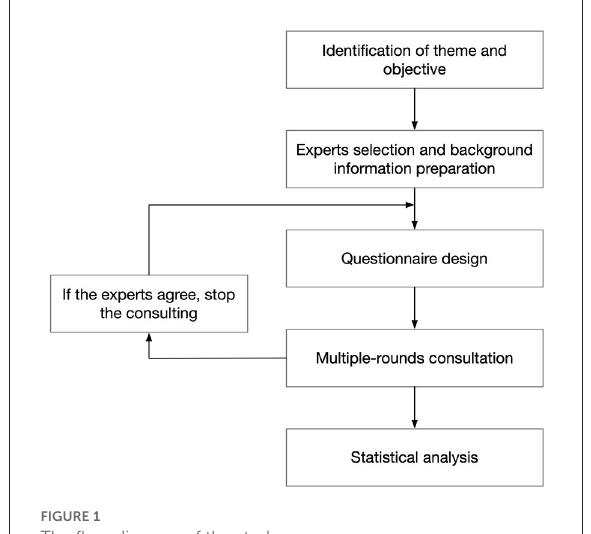
FIGURE1 The flow diagram of the